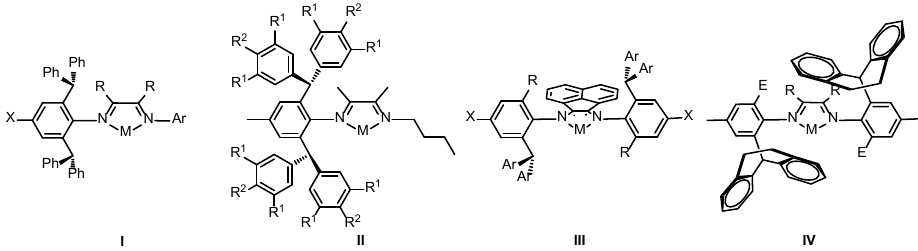
Scheme 1. Selected examples of the unsymmetrical strategy on α -diimine nickel and palladium sys- tems (M = Ni or Pd).